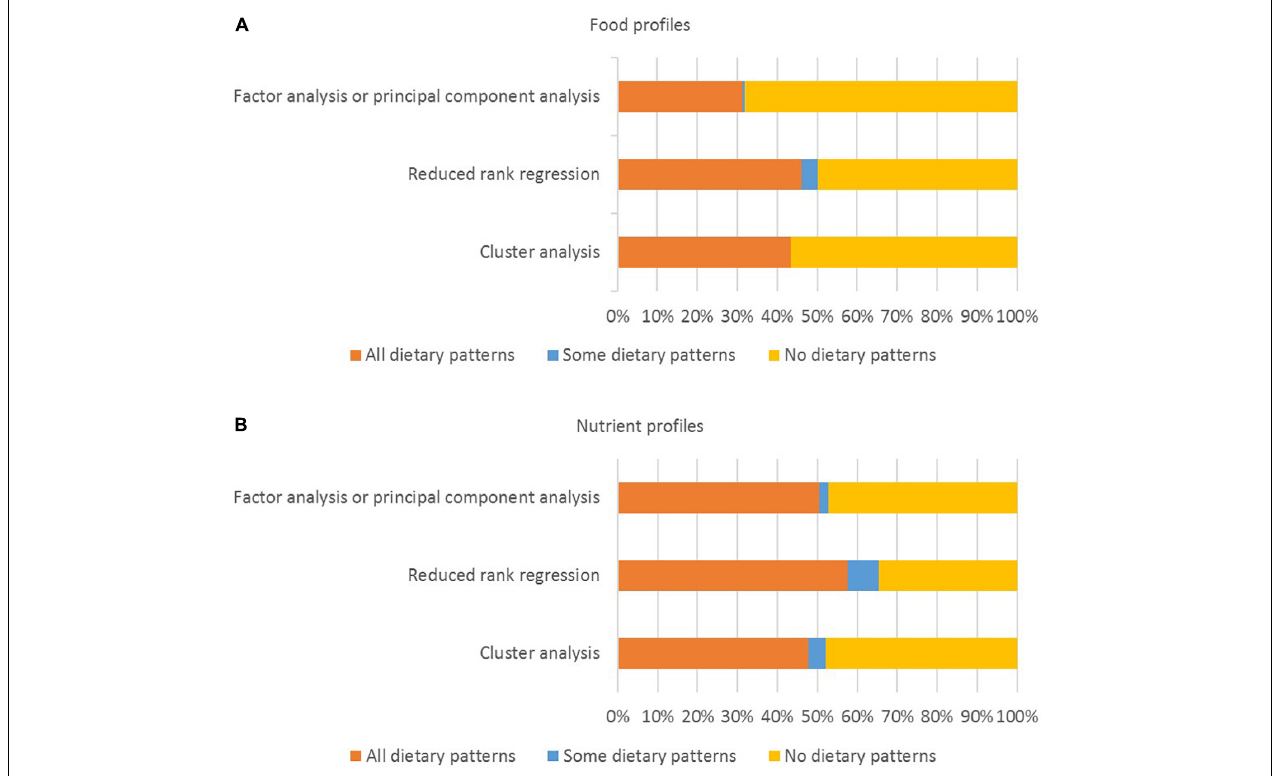
FIGURE 4 | Percentage of studies for which (A) food profiles and (B) nutrient profiles were reported ( n = 167 studies).